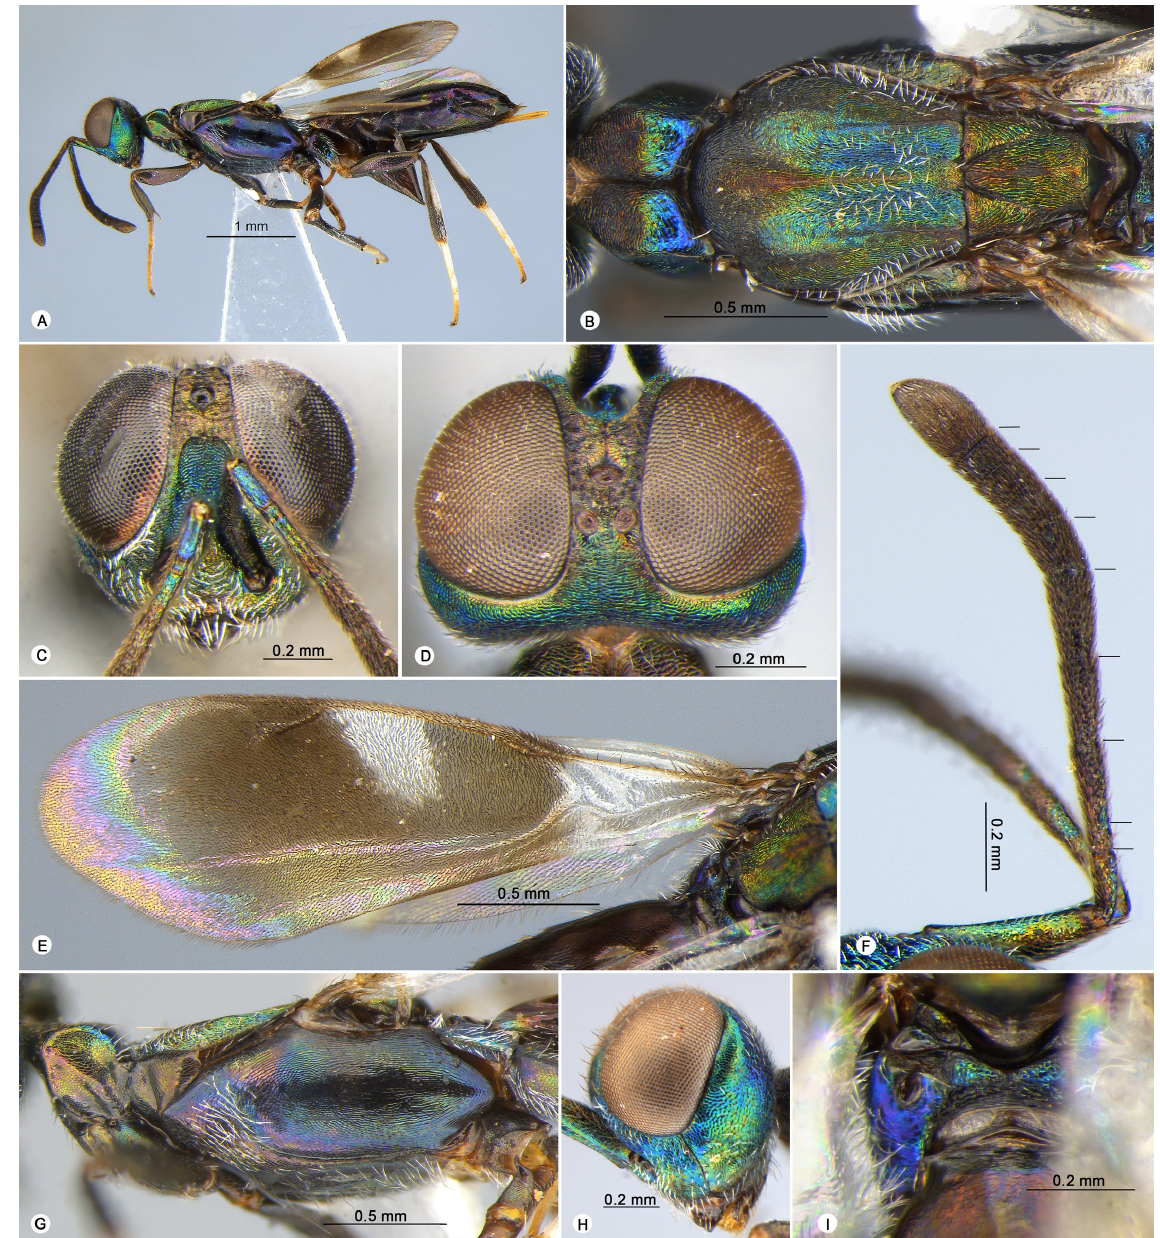
Fig. 5. Zaischnopsis campaniformis Tang & Peng sp. nov. A . Body, lateral view. B . Mesosoma, dorsal view. C . Head, front view. D . Head, dorsal view. E . Fore wing. F . Antenna. G . Mesosoma, lateral view. H . Head, lateral view. I .